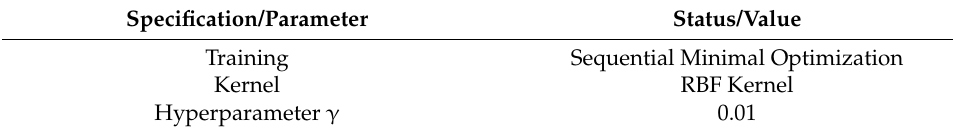
Table 6. Specifications and parameters of support vector regression